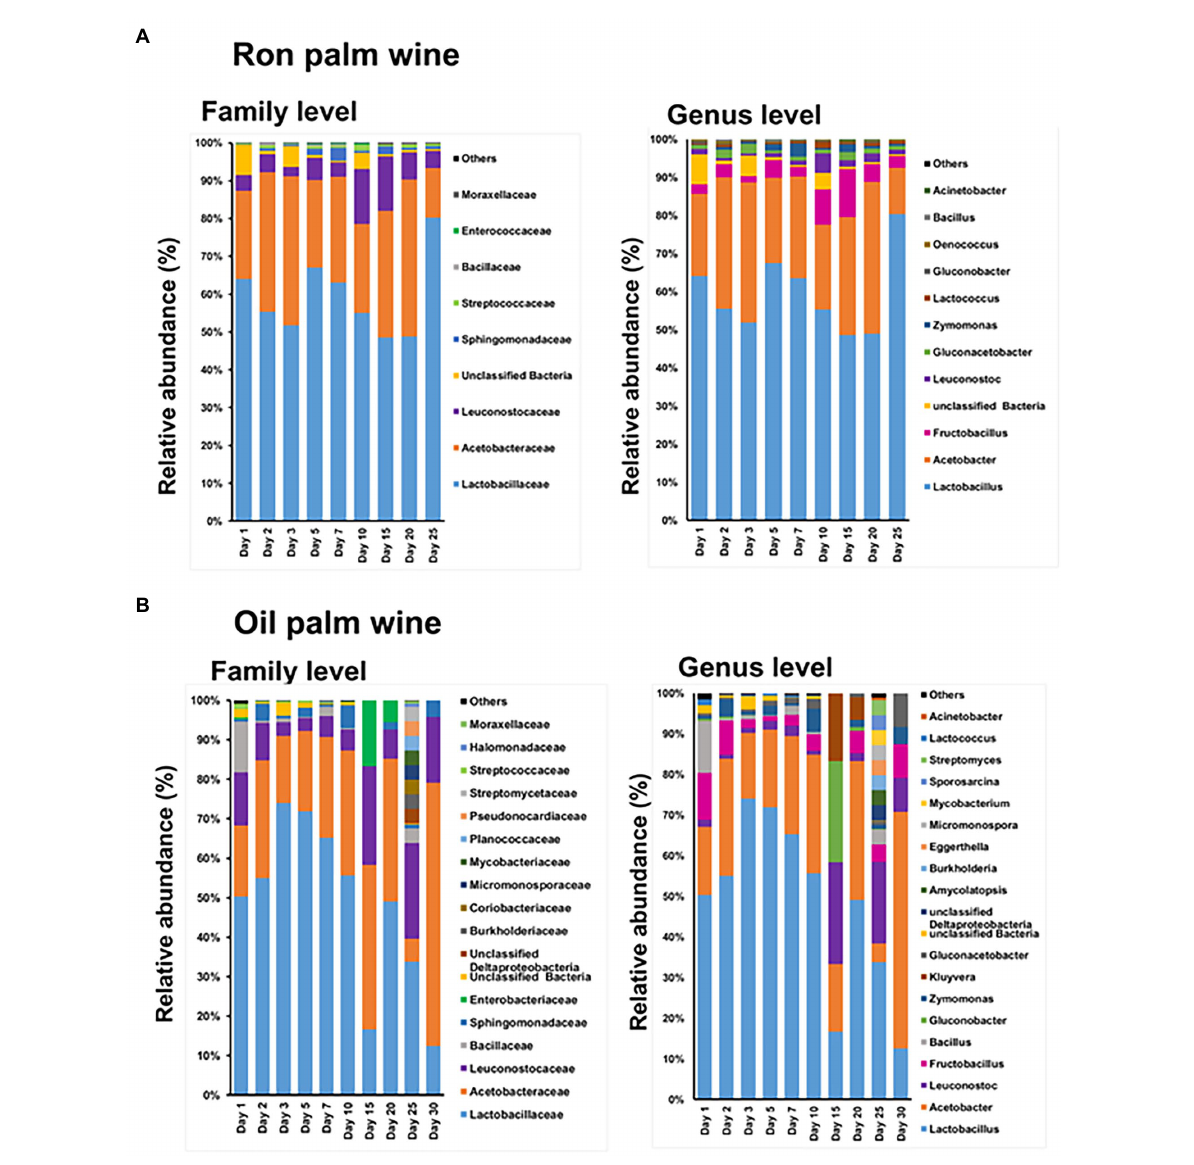
FIGURE 3 The bacterial taxon bar chart shows the dynamics in the relative abundance (%) of predominant bacteria at family-level and genus level during ron palm wine (A) and oil palm wine (B) tapping days. The bacterial taxa with a mean relative abundance of <1% across the samples are combined and shown as